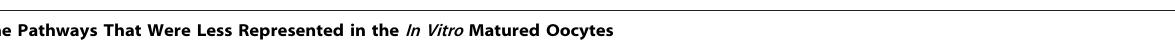
Gene Pathways That Were Less Represented in the InVitro Matured Oocytes